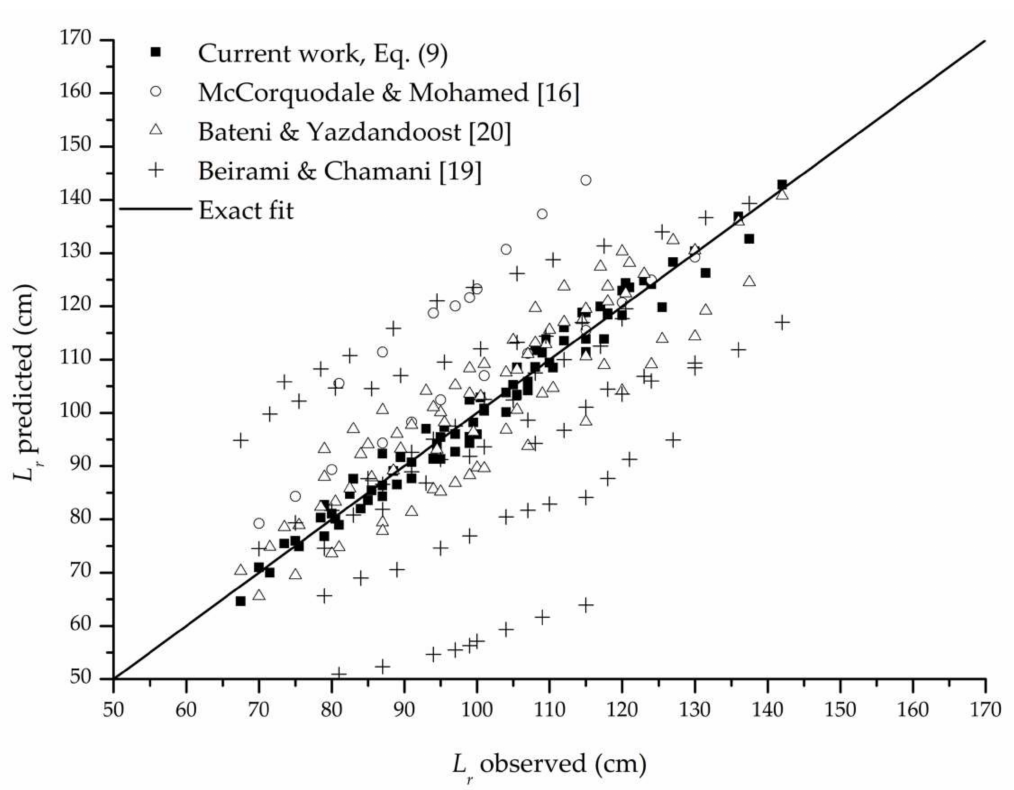
Figure 4. Observed vs. predicted roller lengths for F and B-F type jumps.